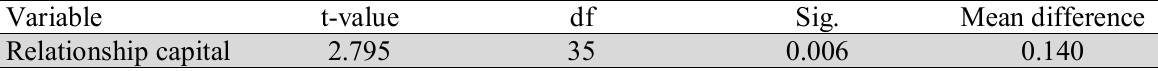
The summary of t-student test for measuring the effect of relationship capital